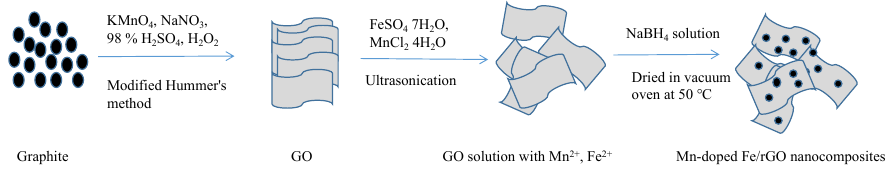
Figure 2. Schematic of Mn-doped Fe/rGO nanocomposite synthesis.